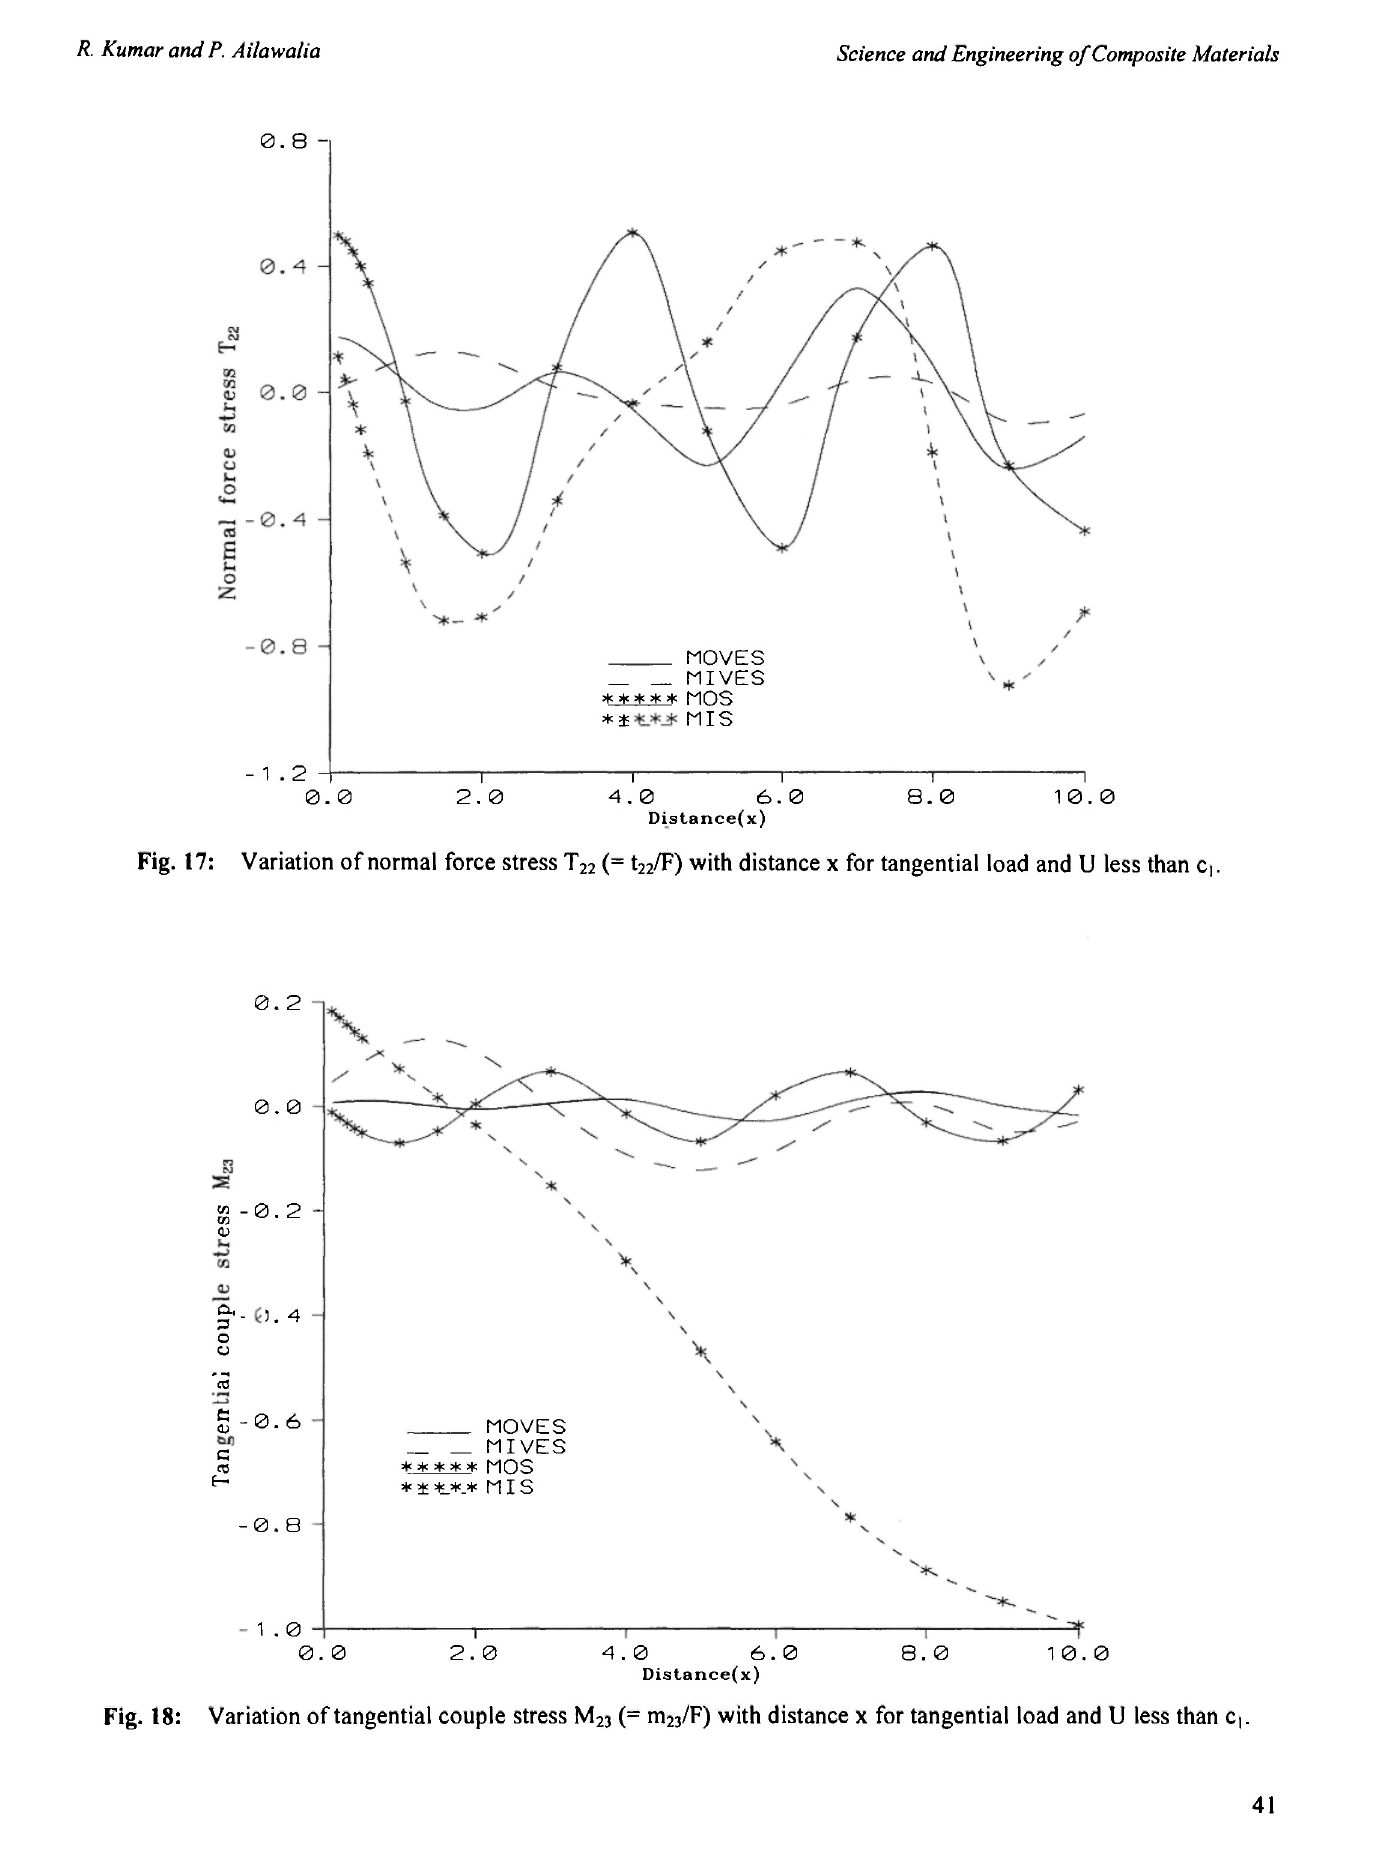
Variation of tangential couple stress M 23 (= m 23 /F) with distance χ for tangential load and U less than